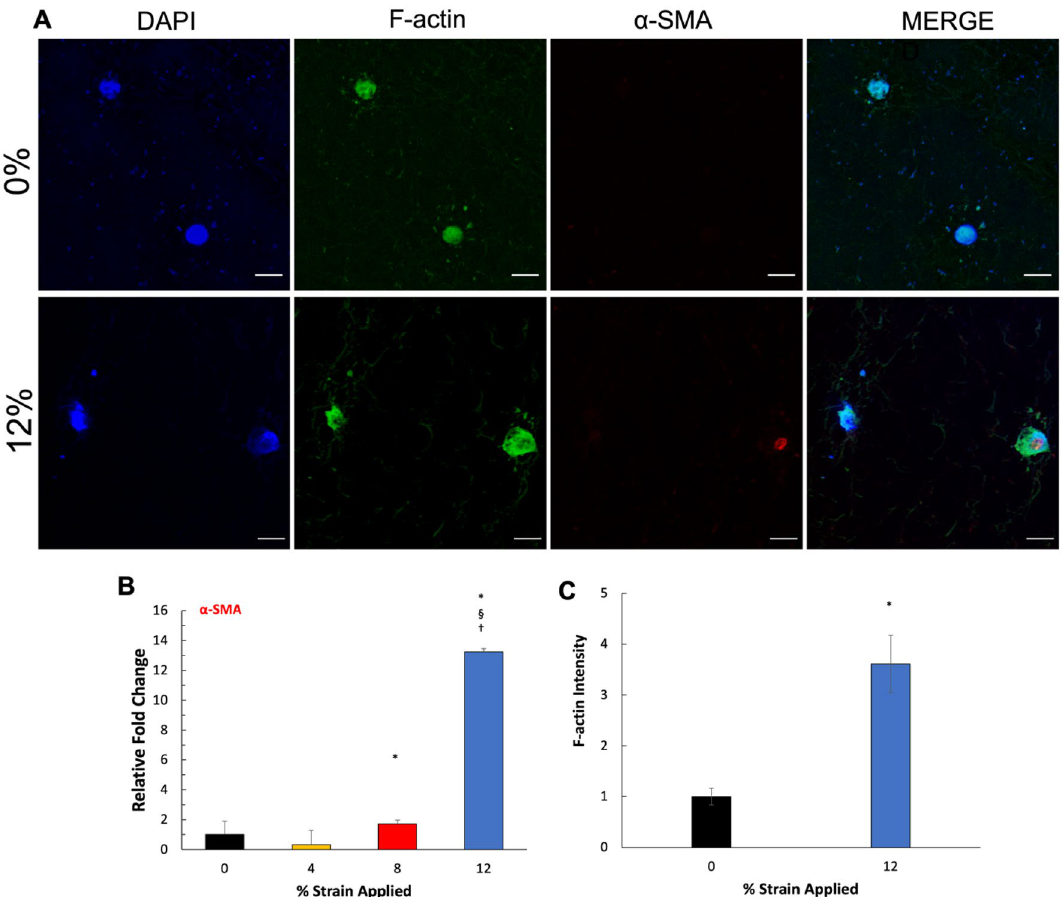
Figure 9. Mechanical strain induces FMT in 3D tissue analogues. ( A ) α-SMA IHC staining of 0% (control) and 12% strain group, ( B ) relative gene expression of α-SMA, ( C ) F-actin immunostaining (green), and nucleus staining (blue) within 3D tissue analogues. Scale bar represents 10 μm. ( C ) Relative F-actin fluorescence intensity within 3D tissue analogues. *Indicate significant difference with respect to 0% mechanical strain group (control) with P < 0.05. § Represent a significant difference between 8 and 12% mechanical strain groups, and † represent a significant difference between 4 and 12% mechanical strain groups, each with a 0.05